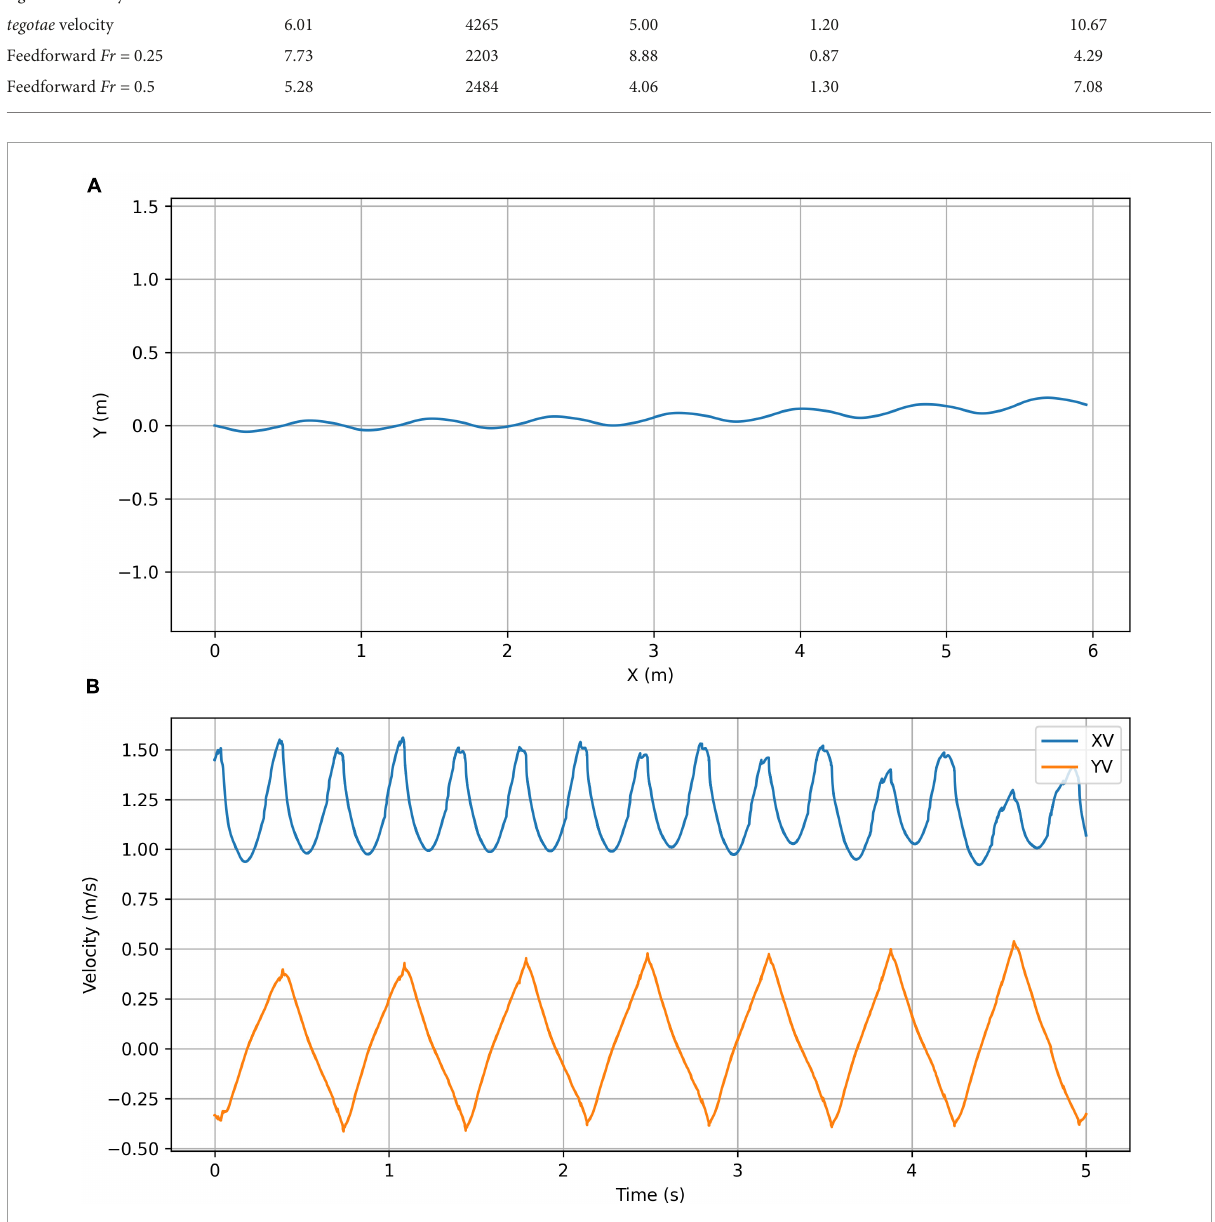
velocity but never drop to zero as was found in non-steady- state examples. The montage frames ( Figures 8 , 9 ) and their respective animations ( Supplementary Videos 4 , 5 ) show much improved gaits compared to non-steady-state examples with much smoother movements. Unlike previous robotics